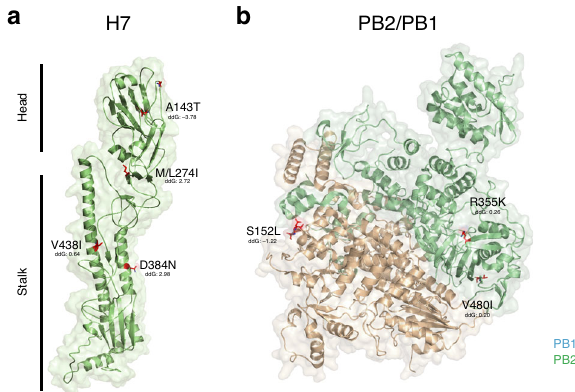
Fig. 4 Functional relevance of HAPMs of H7NX viruses. Protein structure models for the a HA (Hemagglutinin) and the b PB2/PB1 (Polymerase complex) of the H7NX viruses. Functionally relevant HAPMs are highlighted in red within the structural models. Only those HAMPs that are signi fi cantly associated with the HP phenotype are indicated. Estimated values for free energy change (ddG) are indicated for these sites. Negative values or those close to zero can be interpreted as fairly stabilising/neutral mutations with respect to protein